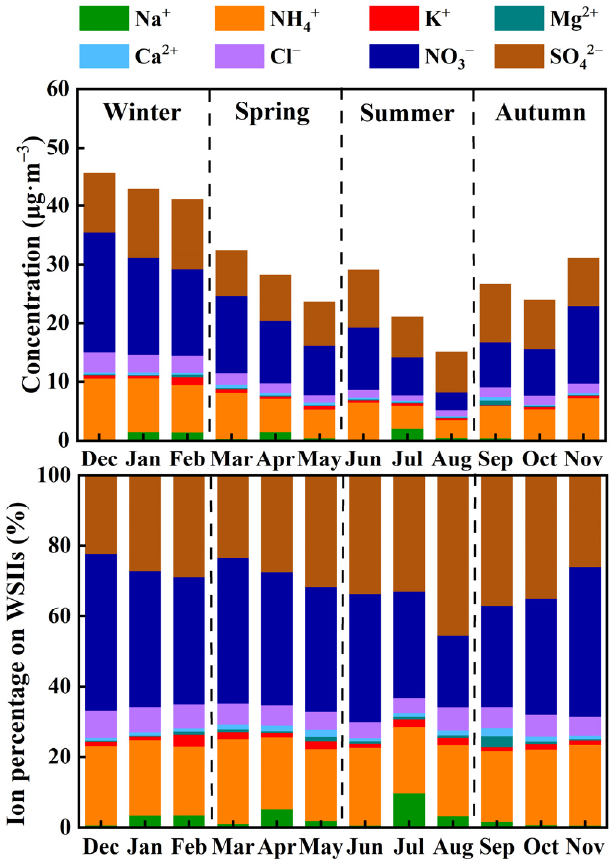
Figure 3. Monthly average concentrations of WSIIs and their percentages.